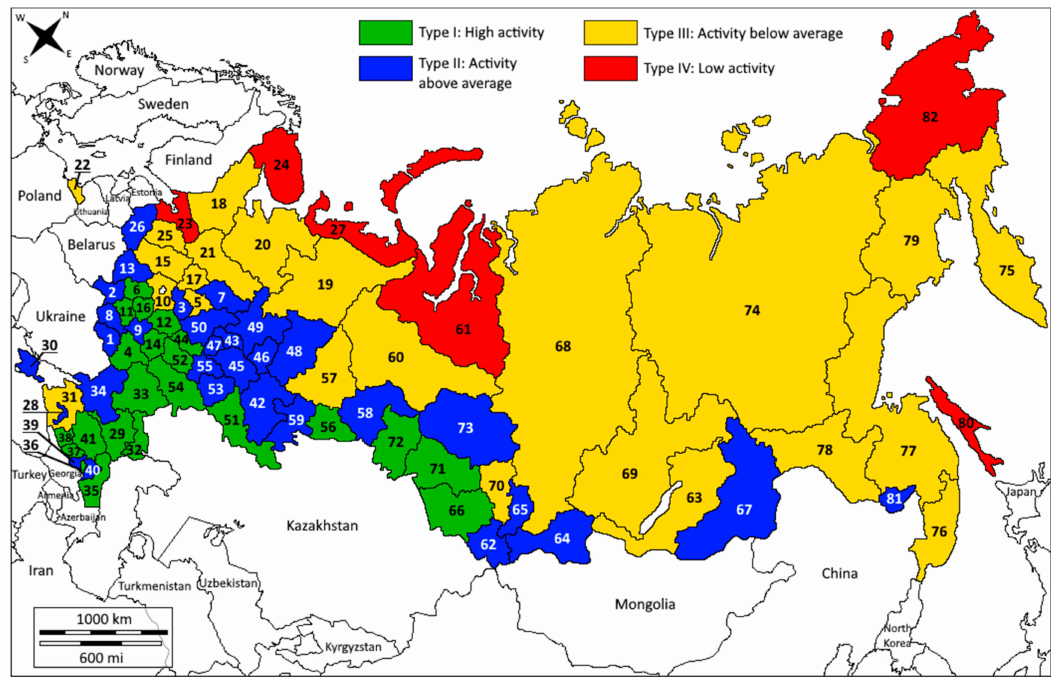
Figure 3. Russian territories: types of agricultural land activity. Note: 1 = Belgorod; 2 =